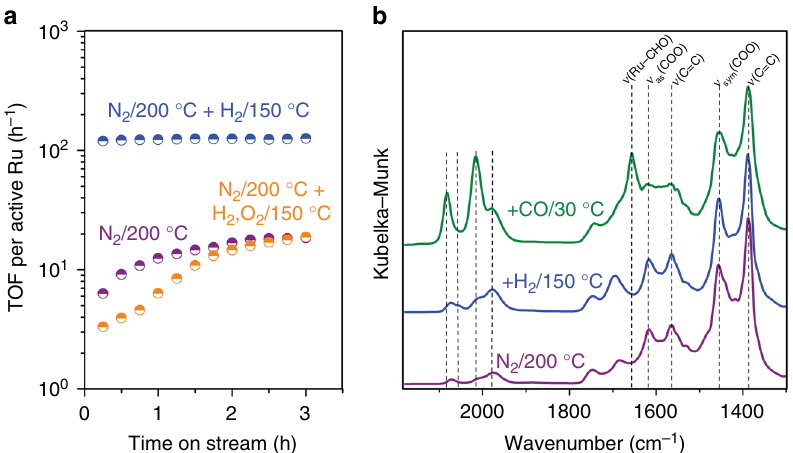
Fig. 2 Catalytic activity and formation of the Ru – H active site in MOF L25 . a Ethylene dimerization TOFs at 50 °C and 4.2 MPa ethylene after activation of MOF L25 in N 2 at 200 °C, in N 2 at 200 °C + H 2 at 150 °C, and in N 2 at 200 °C + H 2 at 150 °C + O 2 at 150 °C. Active Ru corresponds to one metal atom per defective node. b IR spectra after subsequent treatments for MOF L25 : N 2 at 200 °C, H 2 at 150 °C, and CO at 30 °C. All spectra are shown after N 2